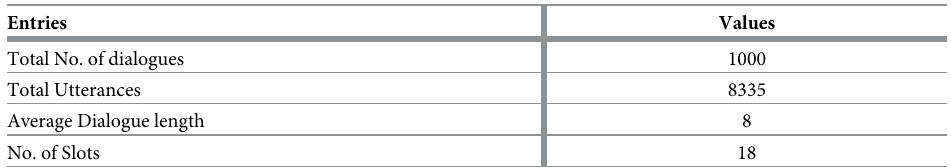
Table 1. Statistics of DevVA dataset.